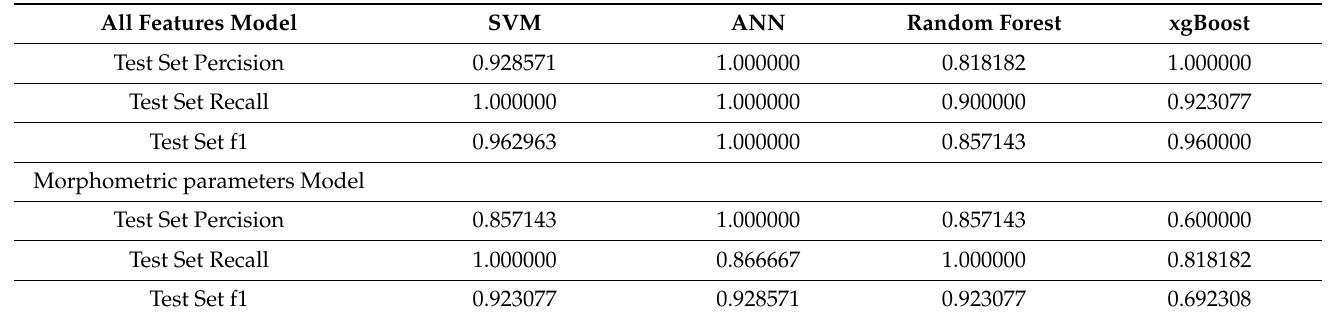
Table 3. Performance Comparison of Machine Learning model in Hydrocephalus Group Compared to Normal Control Group.